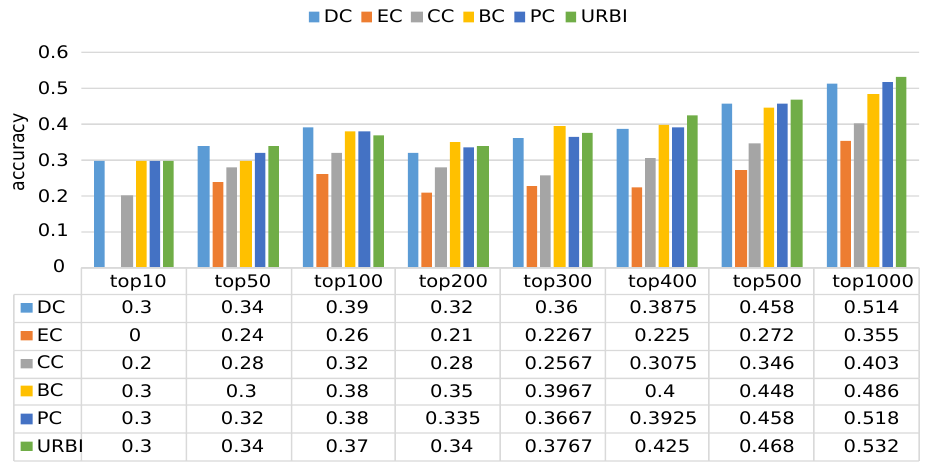
Figure 7. This figure depicts the experimental results of dataset No.7, which contains 7842 book nodes.